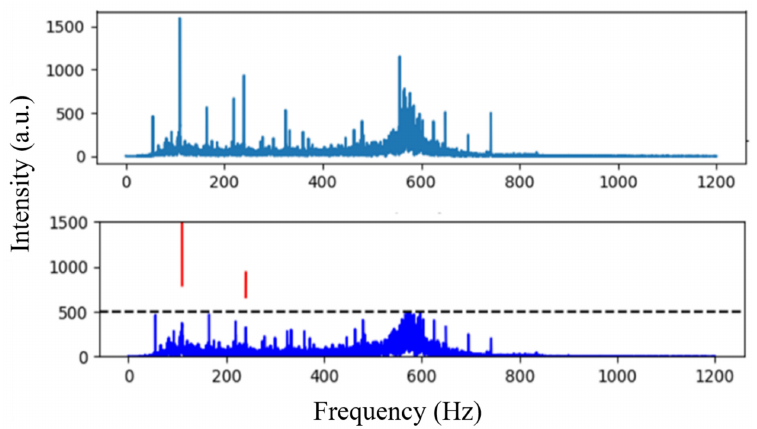
Figure 14. Schematic diagram of automatic encoder restoration error value and threshold value.